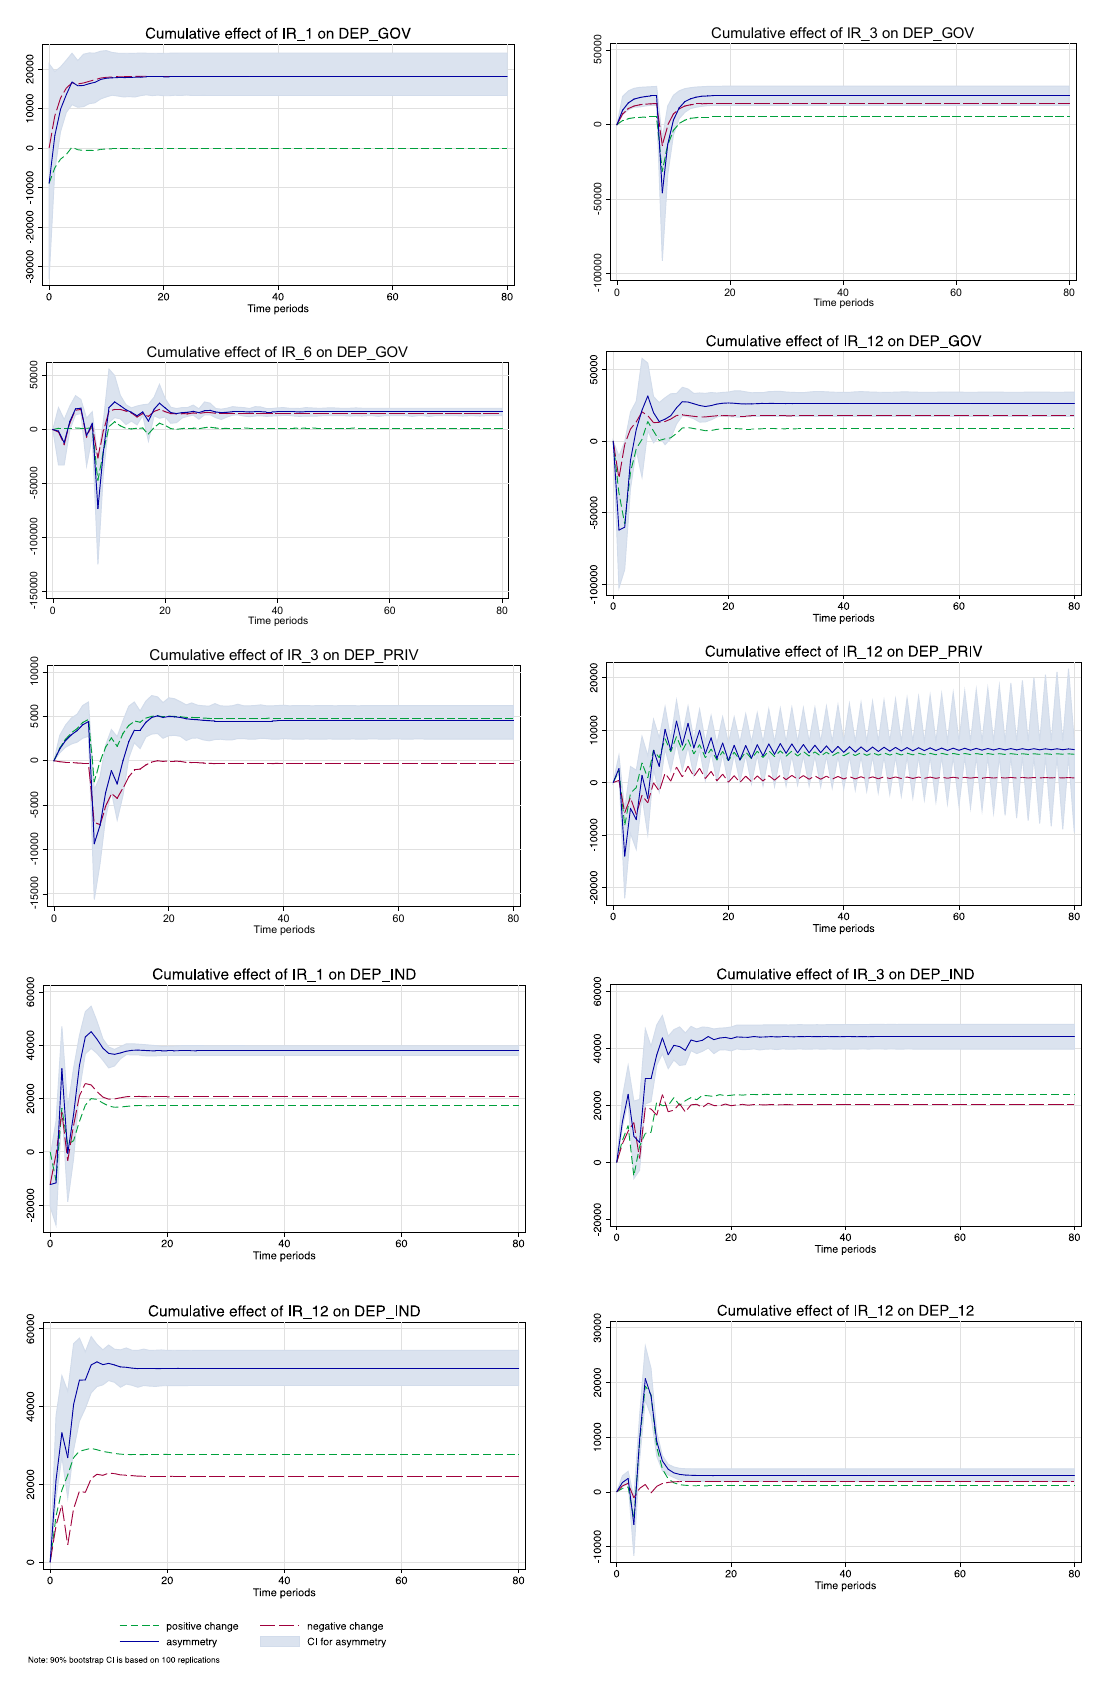
Figure 1. Dynamic multipliers of all significant